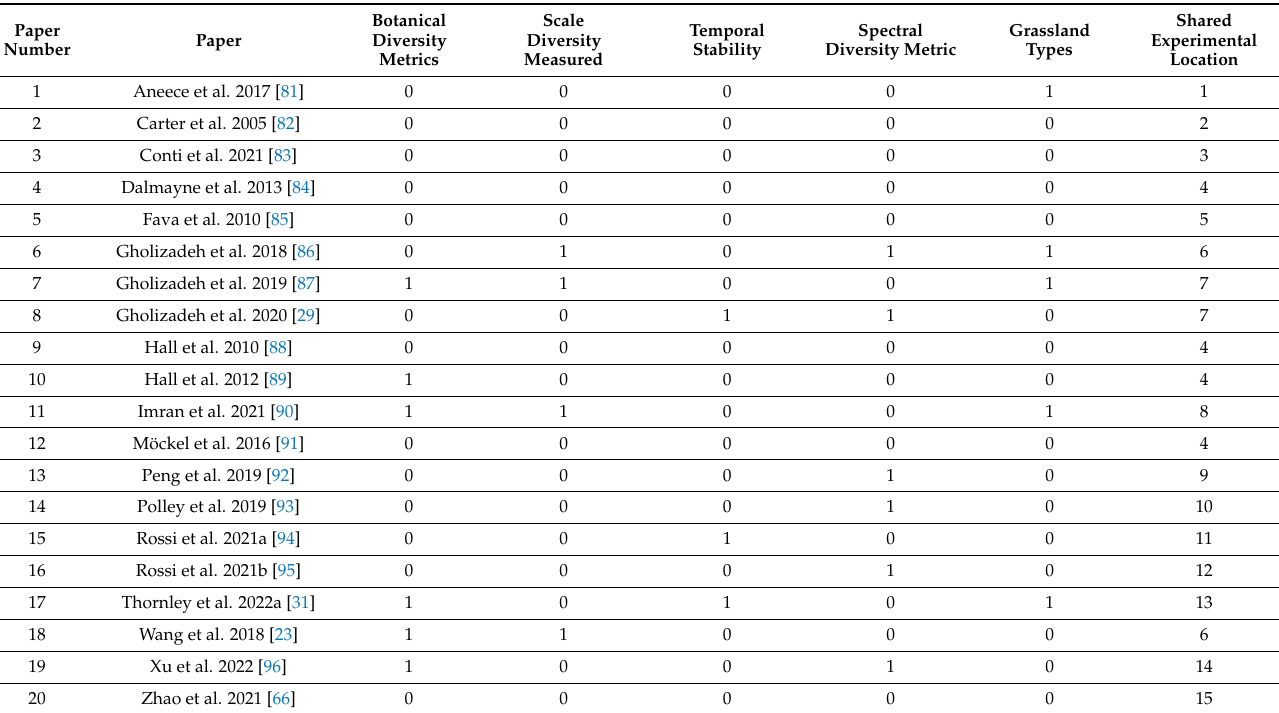
Table 1. An overview of the studies and their thematic focus. Sites that are shared across studies are uniquely